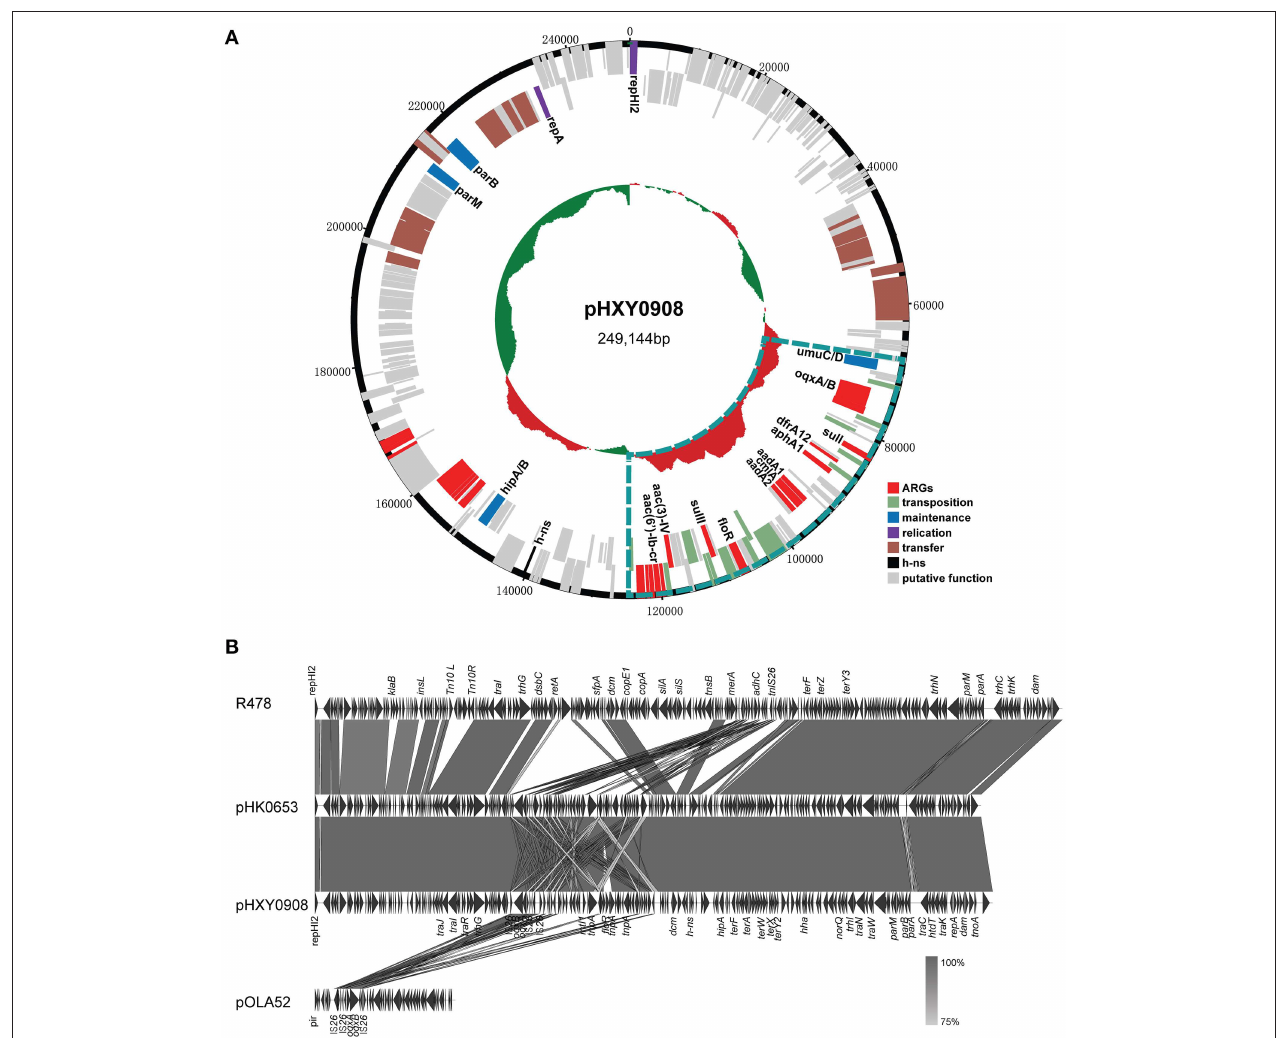
FIGURE 2 | Genetic map and linear comparisons for pHXY0908. (A) Genetic map of pHXY0908. The central region of the map is G + C plot of the nucleotide sequence. Boxes represent ORFs predicted with RAST tools and are color coded after their predicted functions. The blue lines represent the multidrug-resistant regions. (B) Linear comparison of pHXY0908, R478, pHK0653, and oqxAB -positive plasmid pOLA52. The arrows represent ORF position and transcriptional direction. Regions of homology are shaded in gray and functional regions are indicated above and below the linear